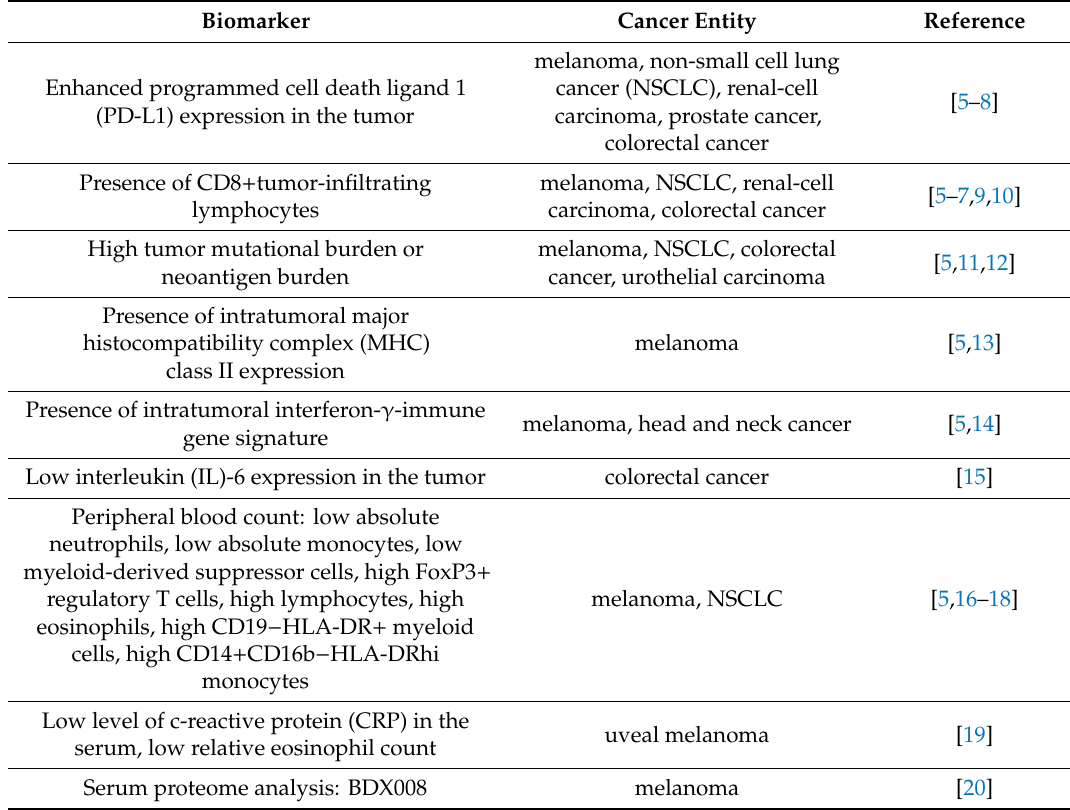
Table 1. Predictive biomarkers sensu stricto of checkpoint inhibitor therapy positively associated with clinical